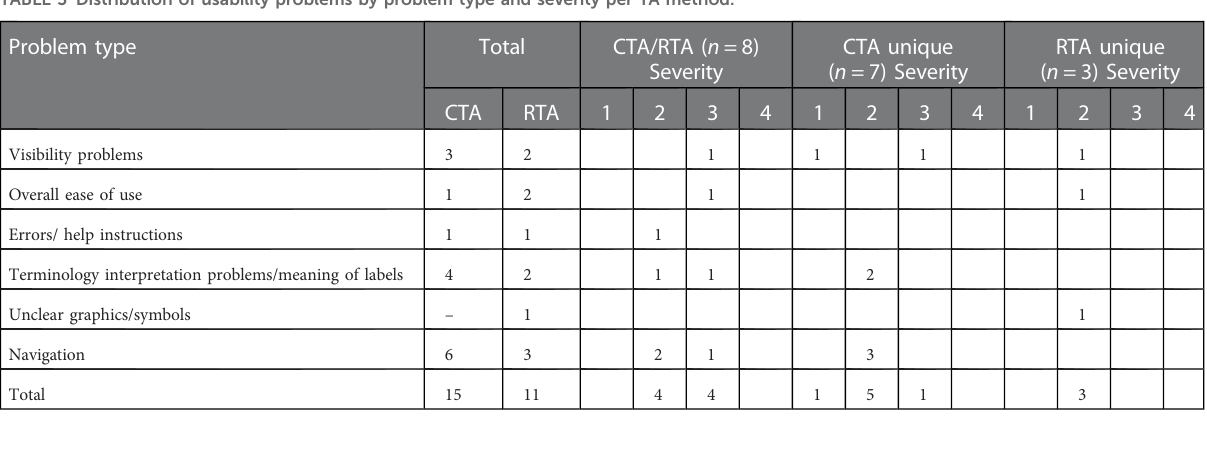
TABLE 3 Distribution of usability problems by problem type and severity per TA method.